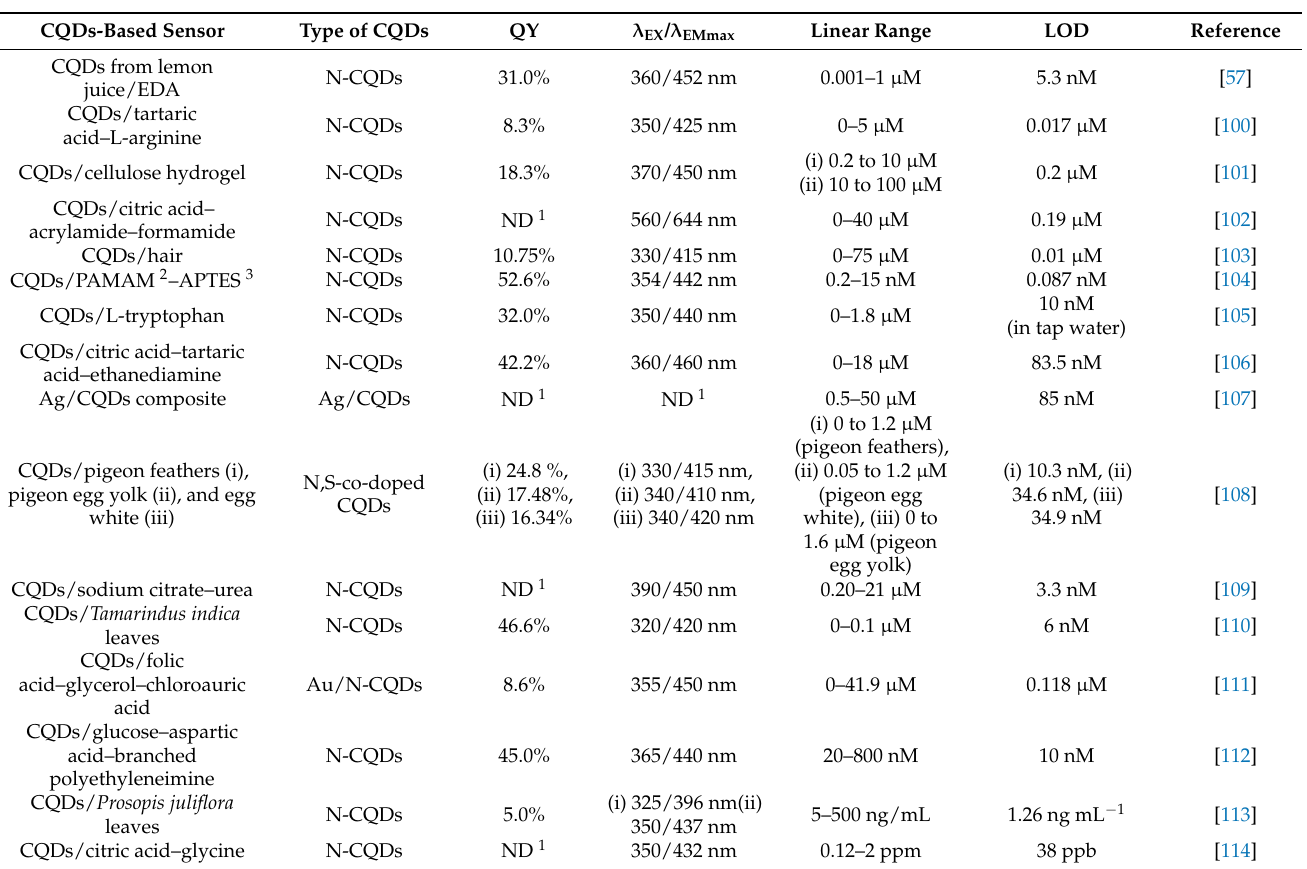
Table 4. Summary of the literature reporting methods of Hg 2+ ions detection of the past five years